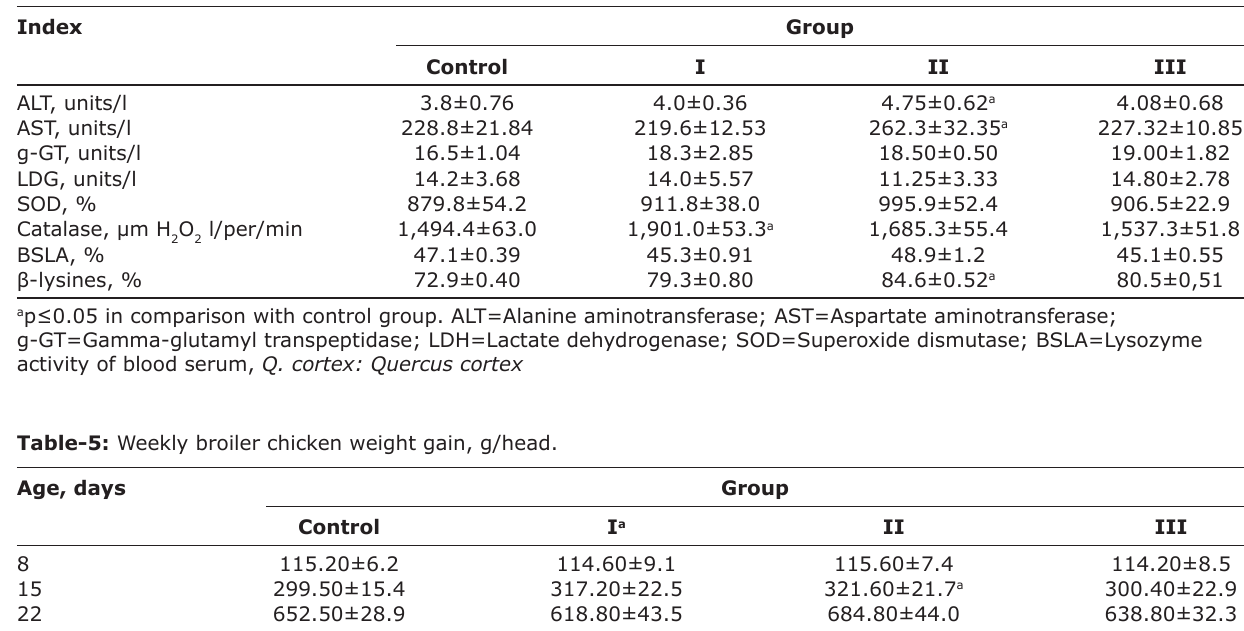
Table-4: Activity of blood serum enzymes and indicators of non-specific immunity in broilers of cross “Smena 8” in the context Q. cortex extract.